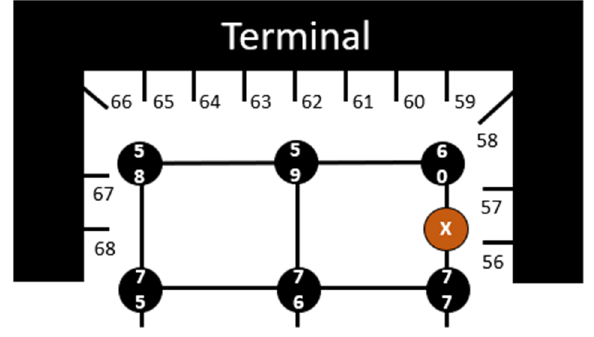
Figure 4. Example of virtual pushback